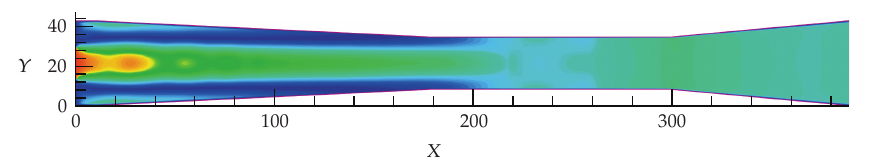
Figure 19: Mach number through the di ff user section at 0.9s.